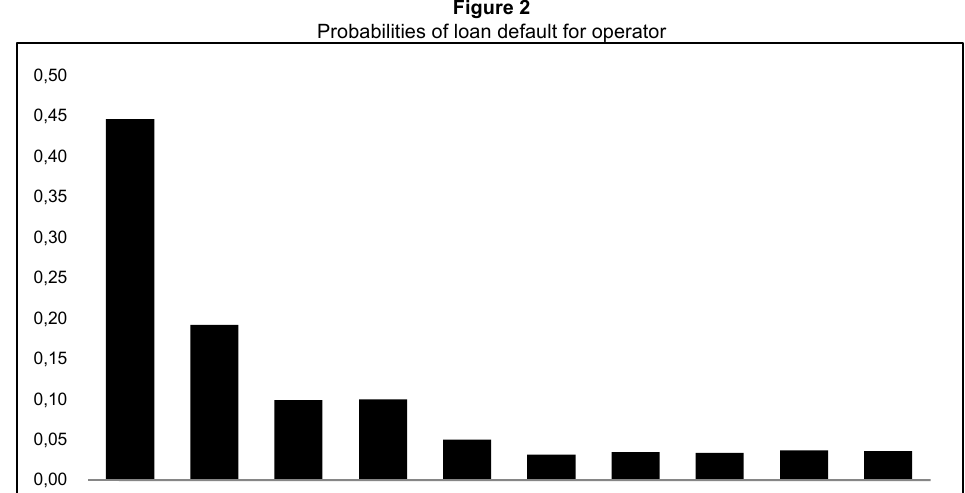
Figure 2 Probabilities of loan default for